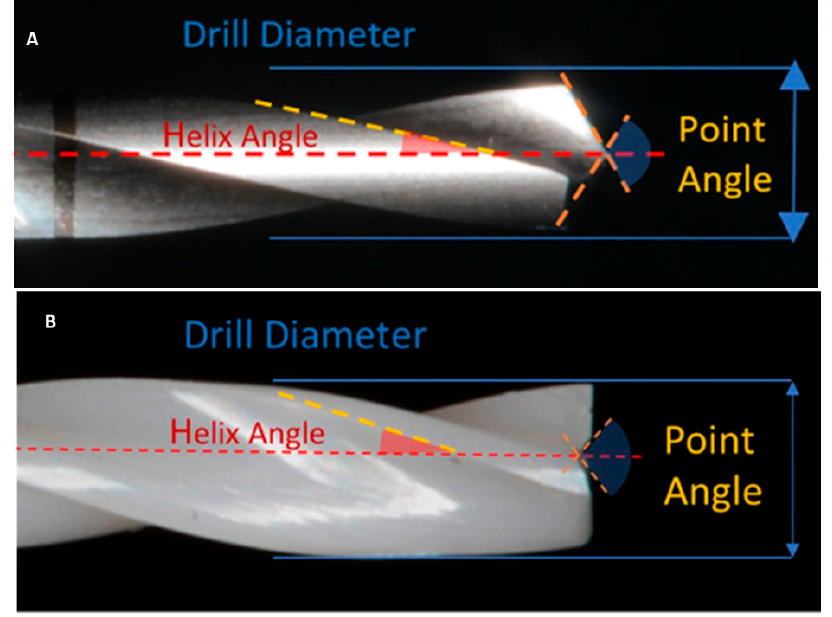
Figure 2. ( A ) Steel cylindrical 2 mm diameter drill with negative point angle ~110°, helix angle ~25°. ( B ) Zirconia cylindrical 2 mm diameter drill with positive point angle ~120°, helix angle ~20°.